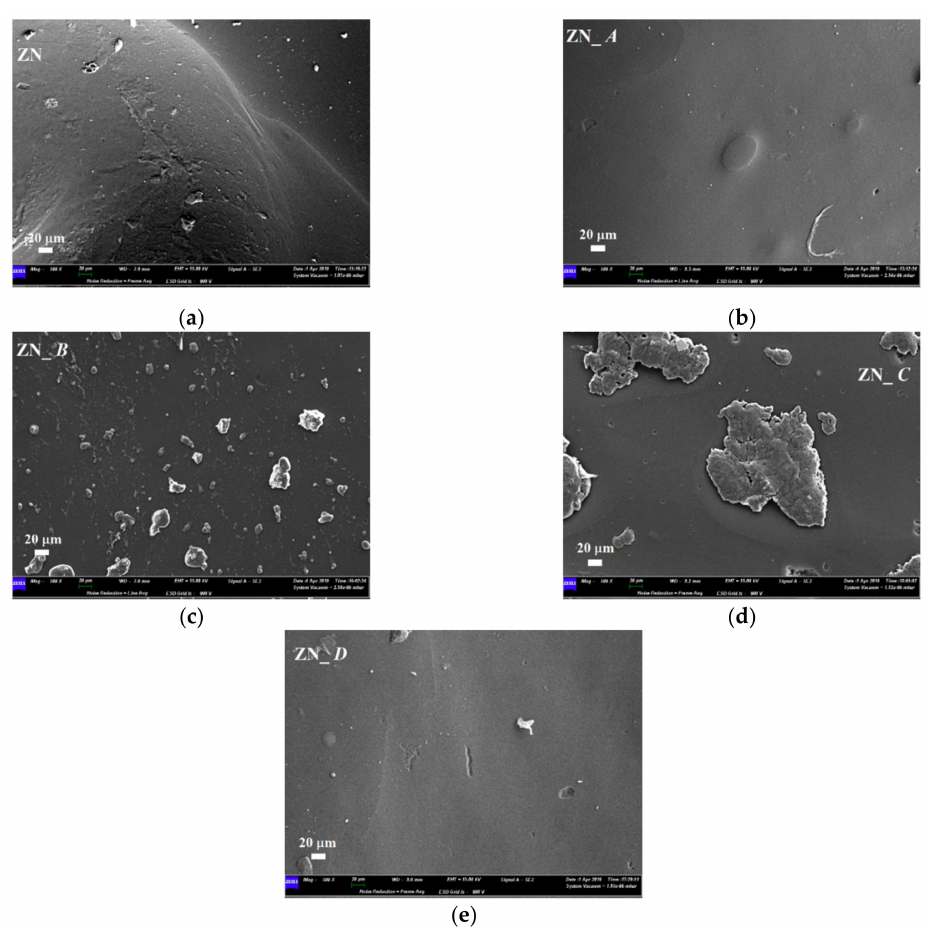
Figure 10. Comparison between SEM micrographs of Zendura (ZN) aligner before and after 2 weeks of immersion into staining beverages; ( a ) as-received sample; ( b ) sample immersed into artificial saliva (A); ( c ) sample immersed into nicotine (B); ( d ) sample immersed into red wine (C); ( e ) sample immersed into coffee